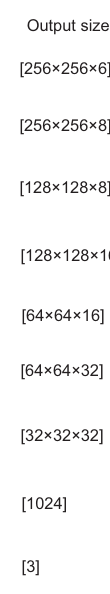
Figure 3. Example of three convolution layer CNN